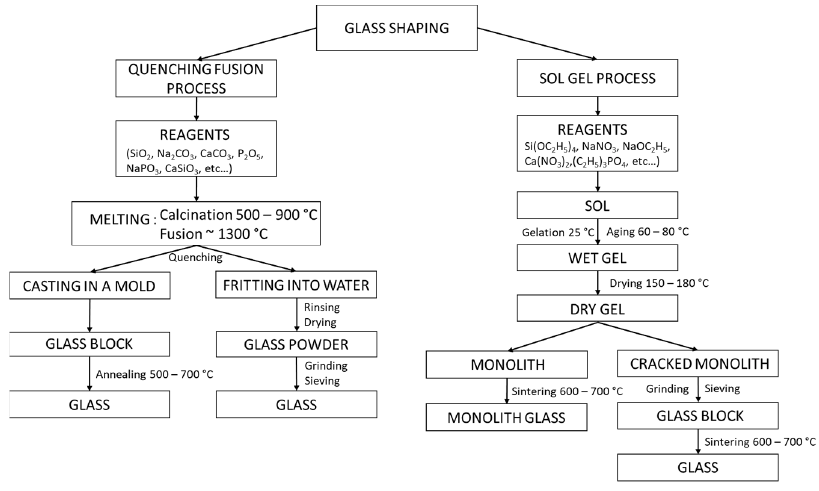
Figure 2. Comparative diagram of quenching fusion process and sol–gel process.